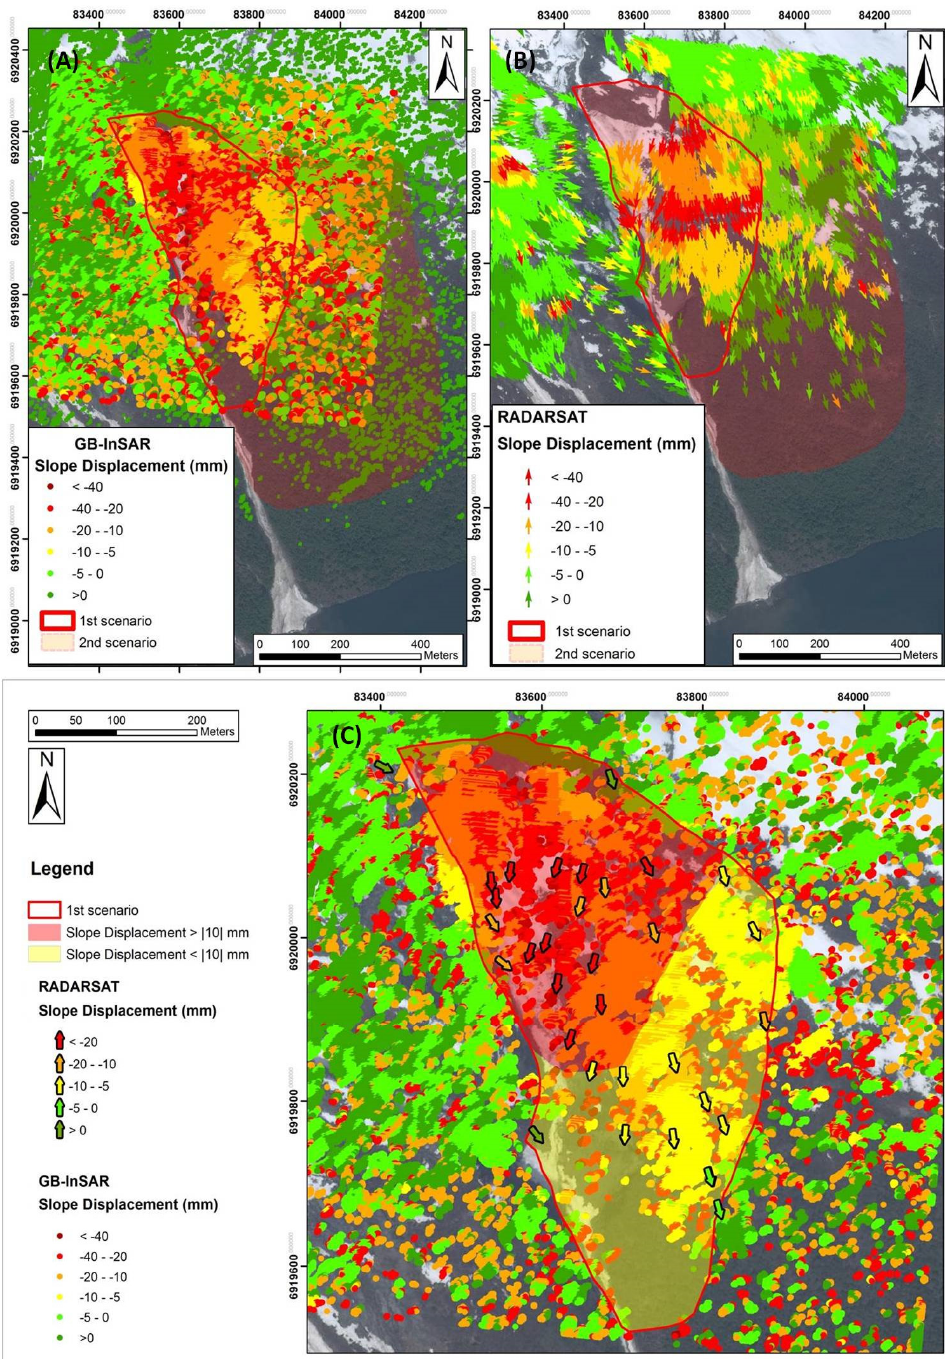
Figure 12. ( A ) Slope displacement (mm) registered by GB-InSAR in the 2010 campaign; ( B ) slope displacement (mm) registered by RADARSAT-2 in 2010; ( C ) GB-InSAR and RADARSAT-2 datasets’ integration. The map in ( C ) shows “real” displacements, detected by the two different platforms; data refer to the period between July and October 2010; the red line corresponds to the landslide limit in the most dangerous scenario (first scenario in Figure 4).